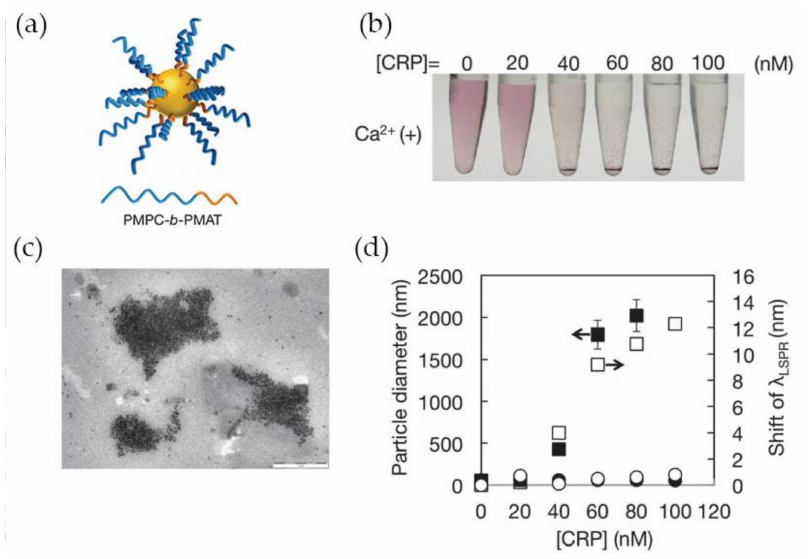
Figure 8. ( a ) Representation of PMPC-b-PMAT-protected Au NPs; ( b ) Photographs of Au NPs in presence of CRP at variable concentration; ( c ) Transmission electron microscope (TEM) image of PMPC-b-PMAT-protected Au NPs after CRP addition; ( d ) Changes in particle diameter (nm) (closed symbol) and λ LSRP shift (open symbol) after addition of CRP without Ca 2+ (circles) and with Ca 2+ 1 mM (squares). Reproduced with permission from ref. [59]. Copyright The Royal Society of Chemistry,